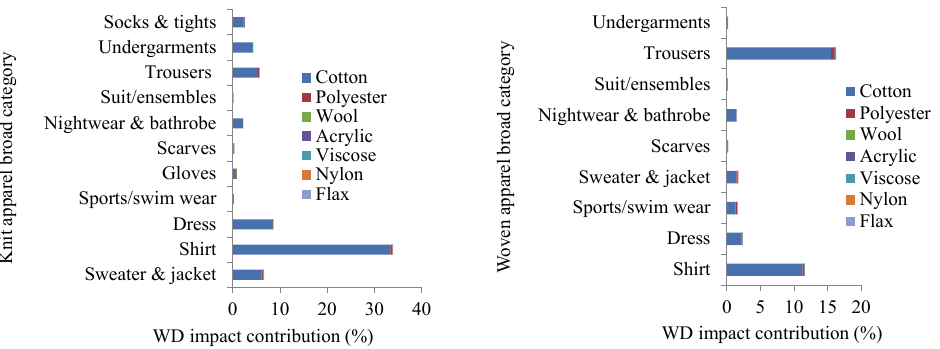
Fig. 13. WD impact contribution of apparel broad categories based on total market share.